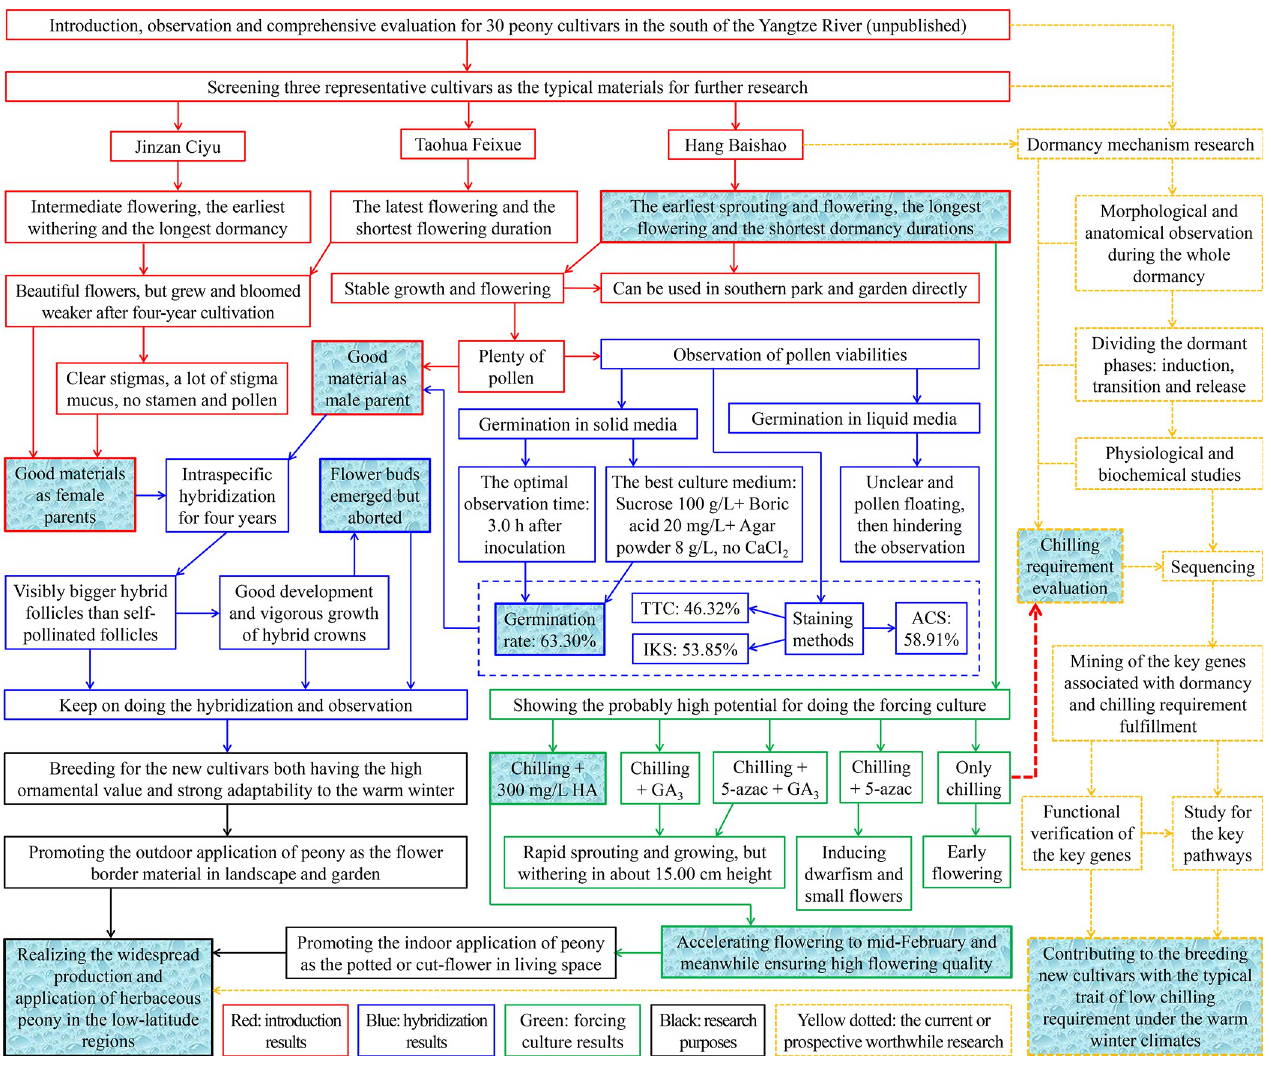
Fig 11. The main results and logistical relationships among different parts of this